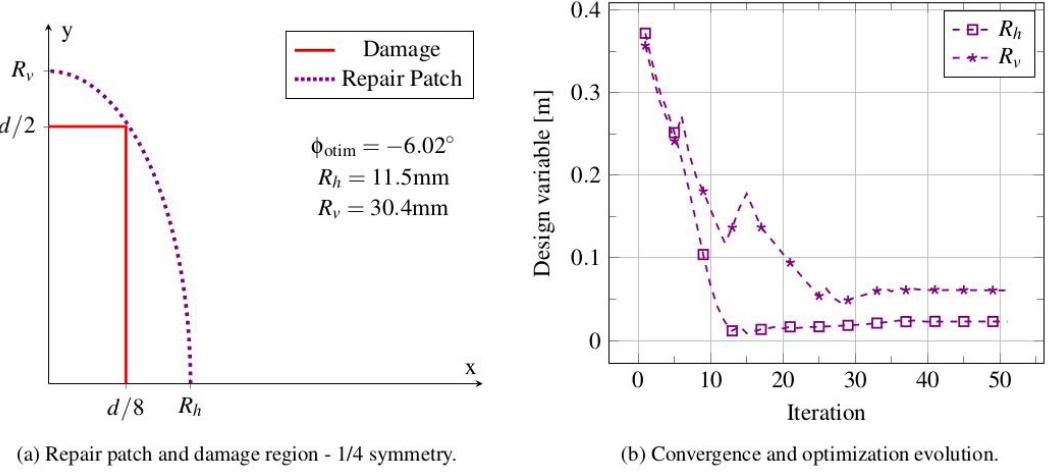
Figure 3. Elliptical repair patch - SS with symmetric stacking